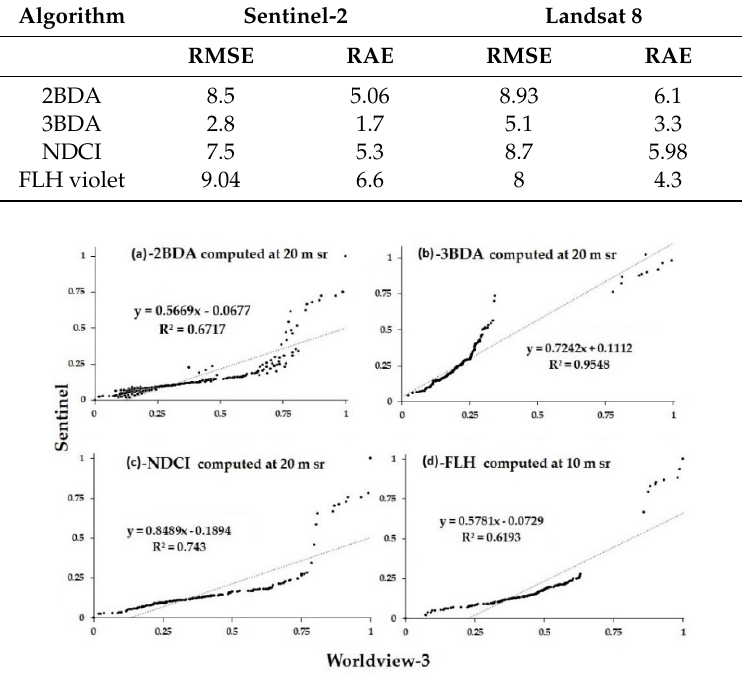
Figure 4. Correlation between Sentinel Chl a concentration and Worldview at their respective spatial resolution (sr).